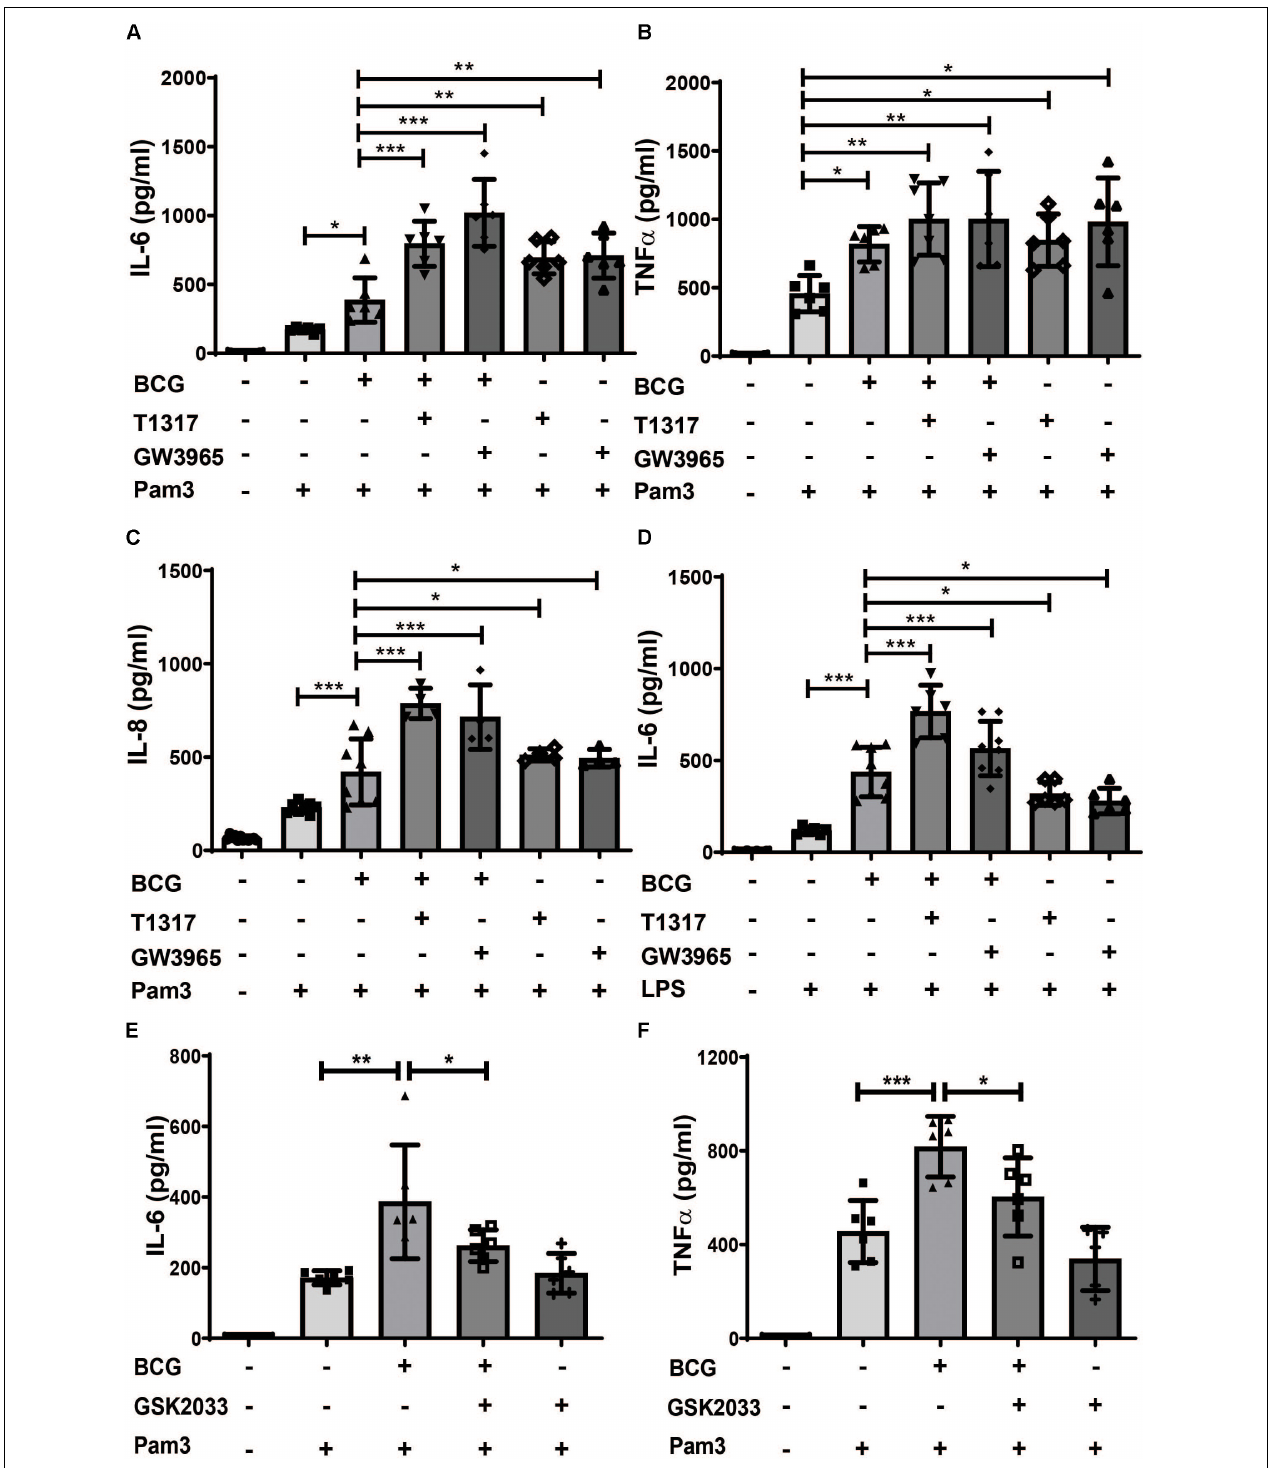
FIGURE 1 | LXR agonists induce a proinflammatory phenotype in human monocytes. Monocytes were treated as indicated with BCG, 2 µ M T1317 (LXR agonist), 10 µ M GW3965 (LXR agonist), 5 µ M GSK2033 (LXR antagonist) or vehicle for 24 h, kept for 5 days in complete medium and restimulated with 5 µ g/ml Pam3cys or 10 ng/ml LPS for 24 h. IL-6 (A,D,E) , TNF α (B,F) and IL-8 (C) were measured in the supernatant. Graphs represent mean values ± SD of six individuals in three different experiments. * P < 0.05, ** P < 0.01, and *** P < 0.001.